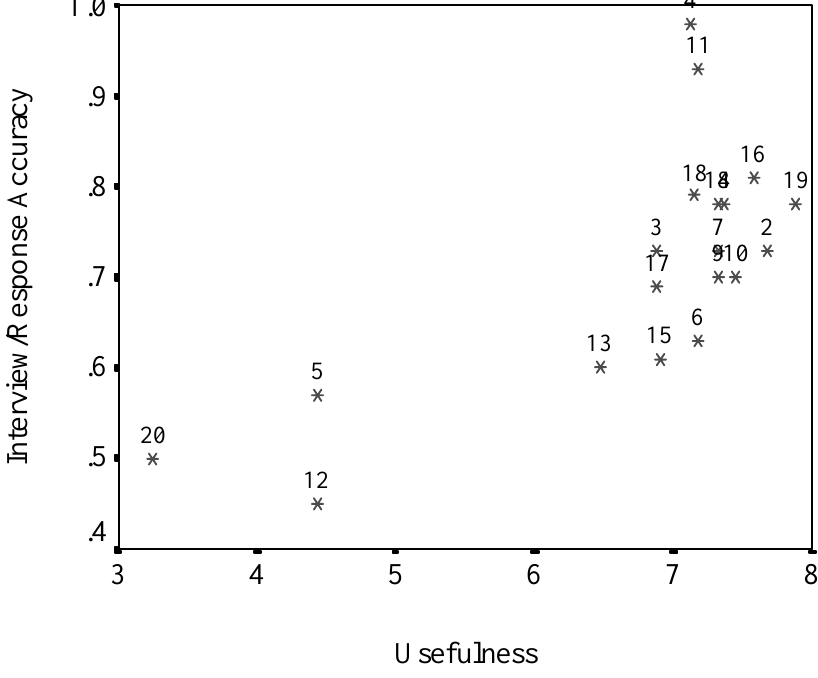
Figure 6a. Response Accuracy from Interview vs Usefulness Score by Sign